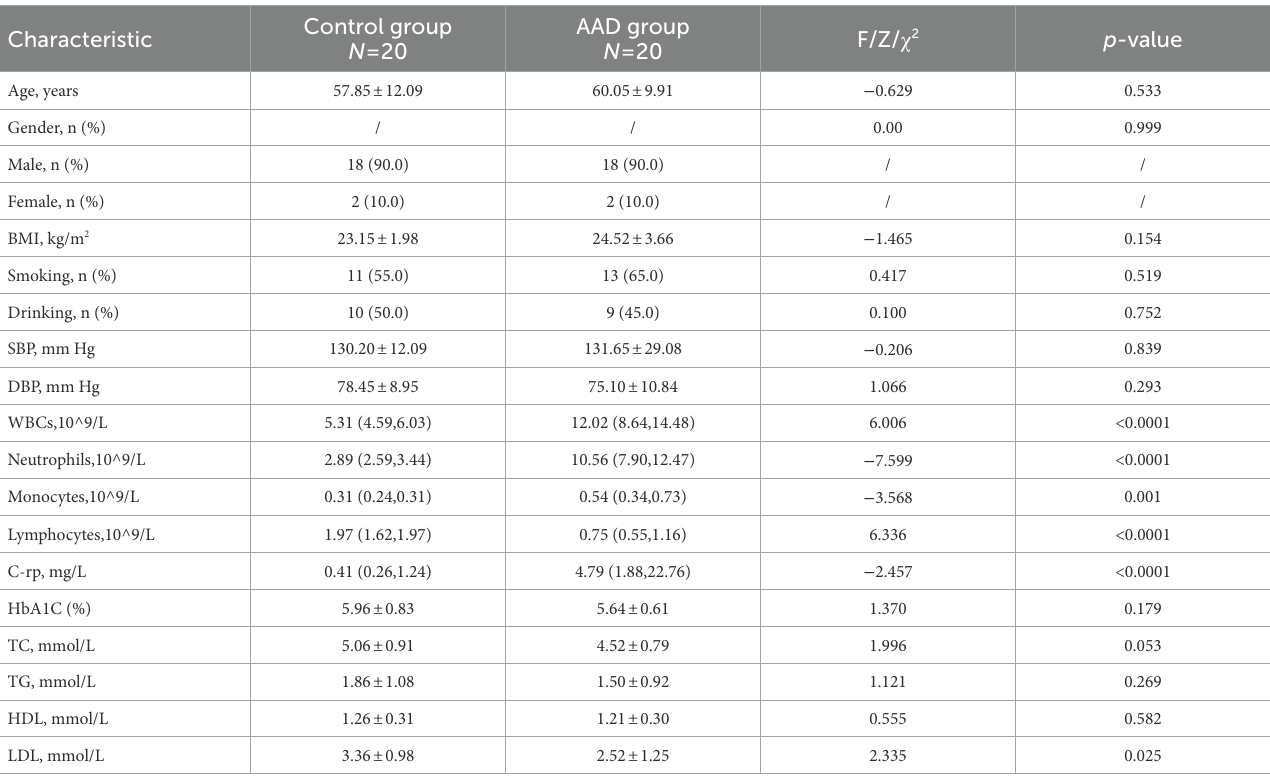
TABLE 1 Demographic and clinical characteristics of subjects.